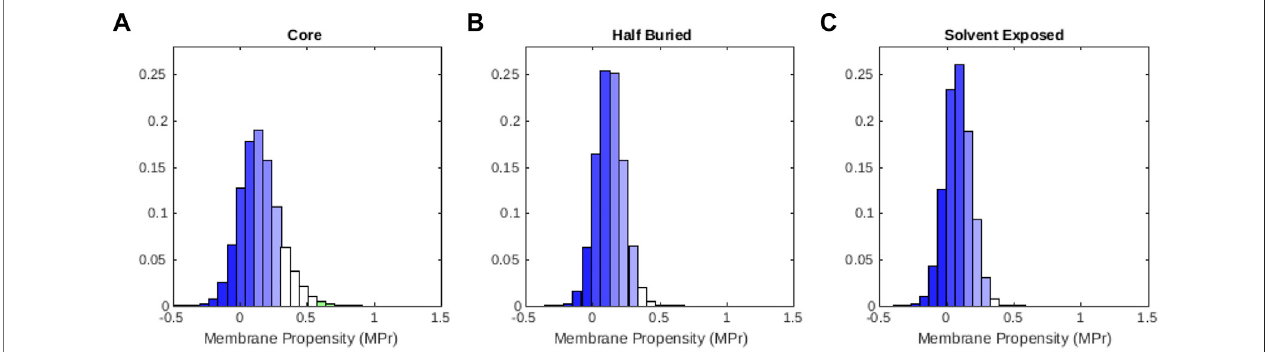
FIGURE 2 | Distribution of MPr scores computed from the globular protein set D glob for residues that are (A) situated in the core, (B) half buried and (C) solvent exposed. The color code is de fi ned in Table 2 .